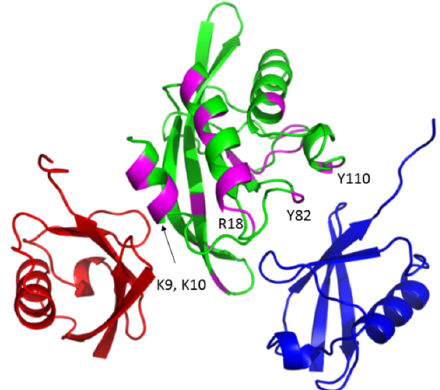
Figure 6. Proximity of tRNA and Ub-binding sites. The model shows the sites of determinants of tRNA binding on the UEV relative to the positions occupied by the proximal domain of K63-linked di-Ub (orange, N-terminal proximal; blue, vestigial active site vicinity). Determinants that recognize tRNA preferentially (located near α -helices-1 and -2) are colored